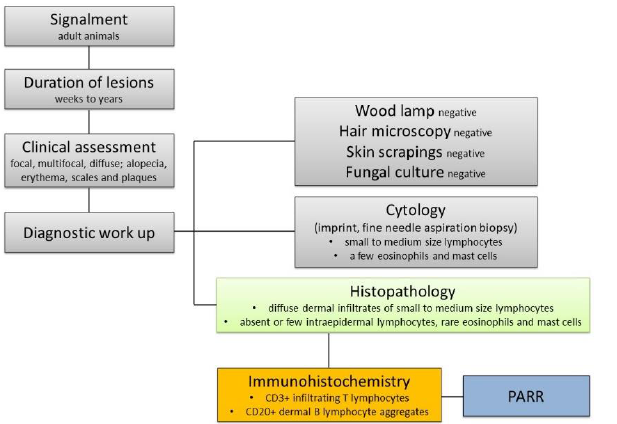
Figure 6. Suggested clinical and diagnostic algorithm in suspected cases of cutaneous lymphocytosis. Supplementary Materials: The following supporting information can be downloaded at: https: //www.mdpi.com/article/10.3390/vetsci9010026/s1, Table S1: Primer nucleotide sequences for PARR assay; Table S2: Score assessment of histological and immunohistochemical findings in cases of feline lymphocytosis; Table S3: Score assessment of histological and immunohistochemical findings in cases of canine lymphocytosis; Figure S1: Frequency of the histological and immunohistochemical findings in feline and canine cutaneous